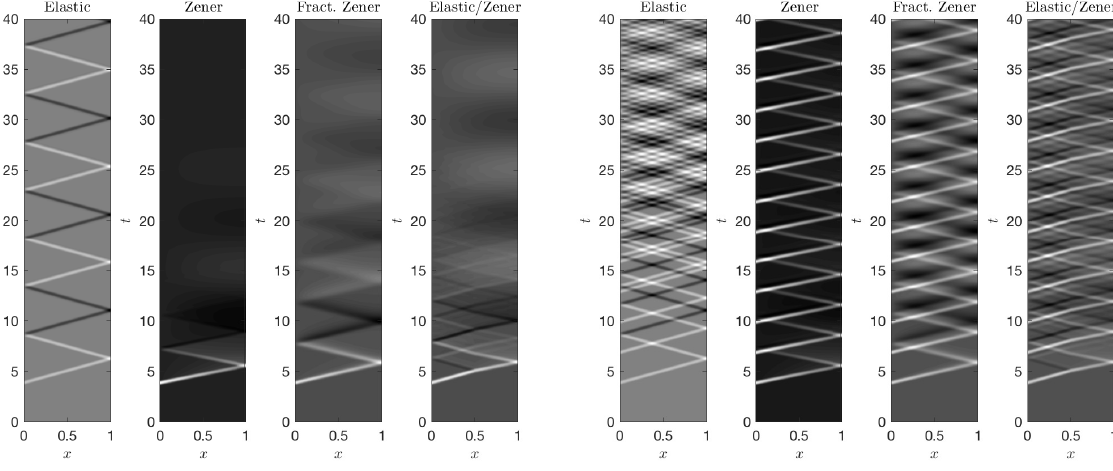
Fig. 6 Space-time plots with parameters described in Table 4 where first and last four subplots correspond to the signals shown on the left and right of Figure